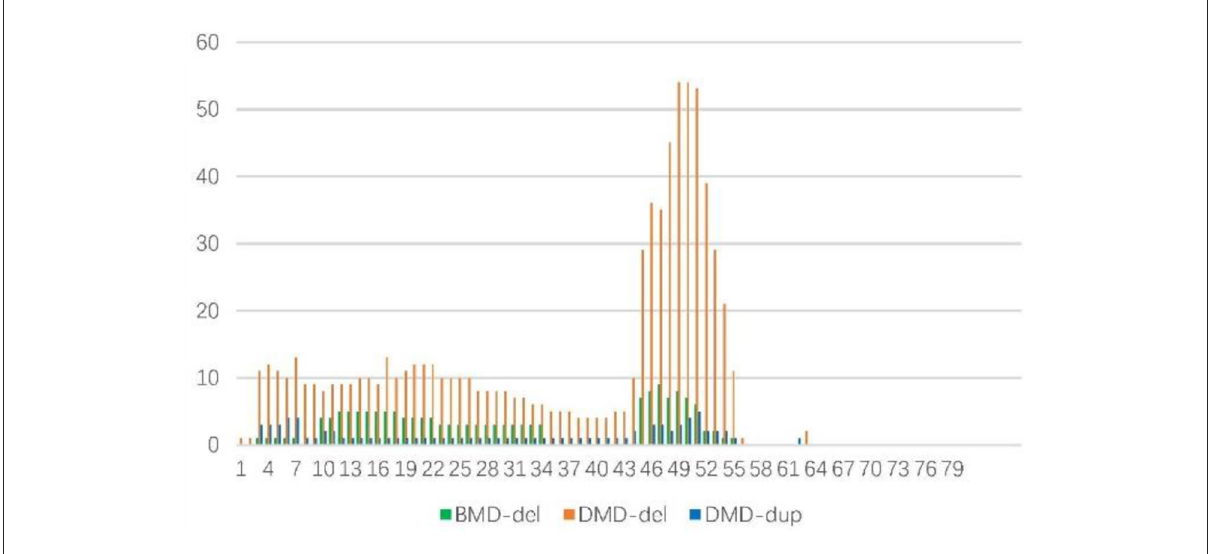
FIGURE3 Frequency of deletions/duplications of DMD gene exons in 169 cases.